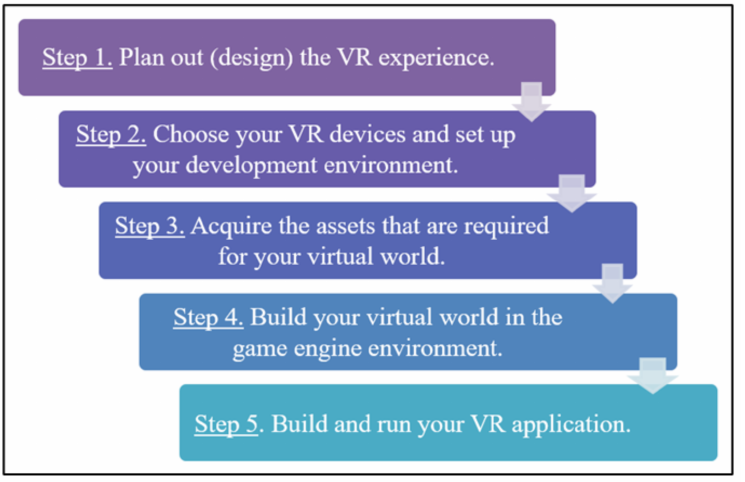
Figure 2. Workflow of the VR system.